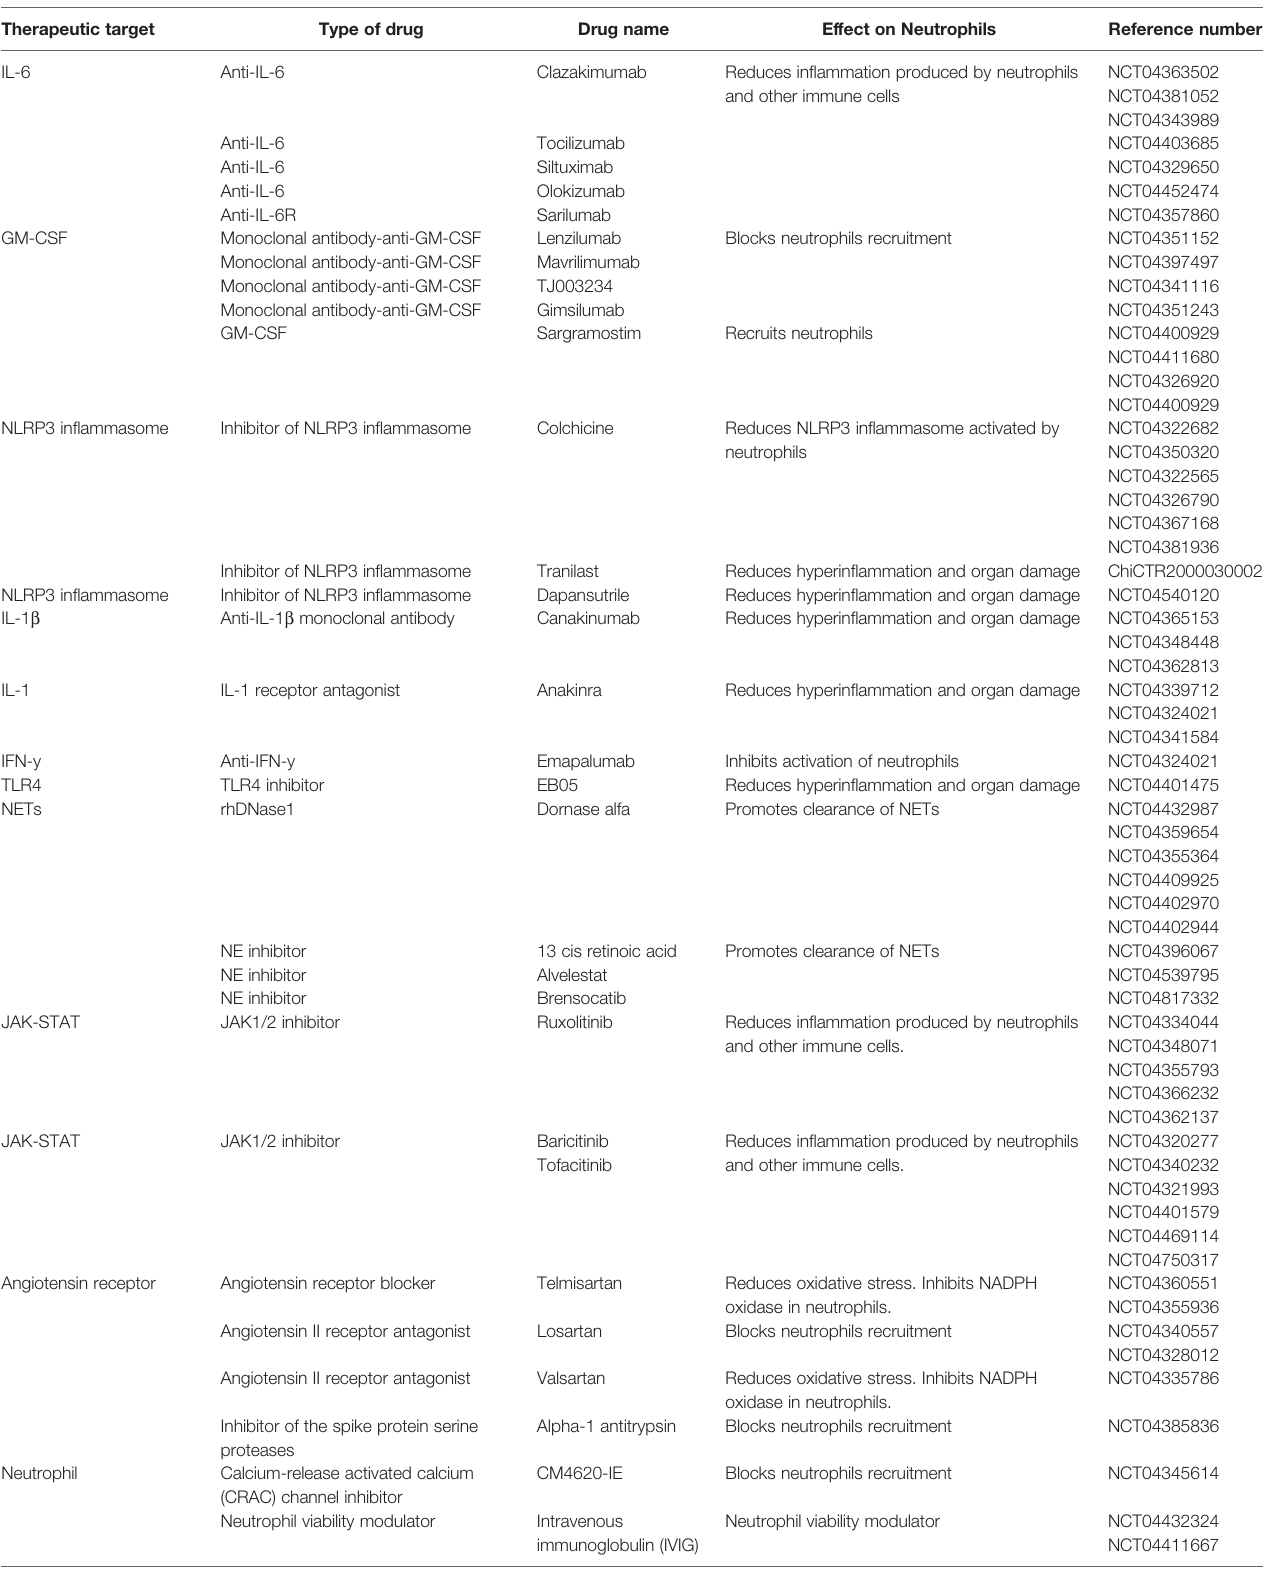
TABLE 1 | Clinical trials therapeutically targeting